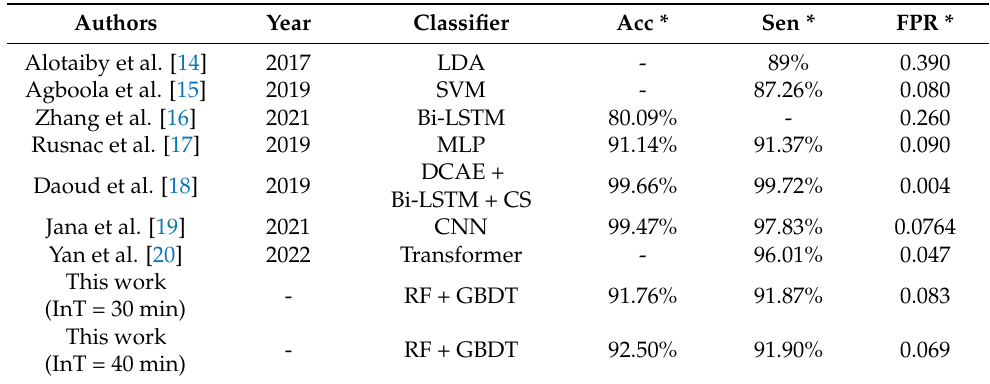
Table 7. Comparison of existing